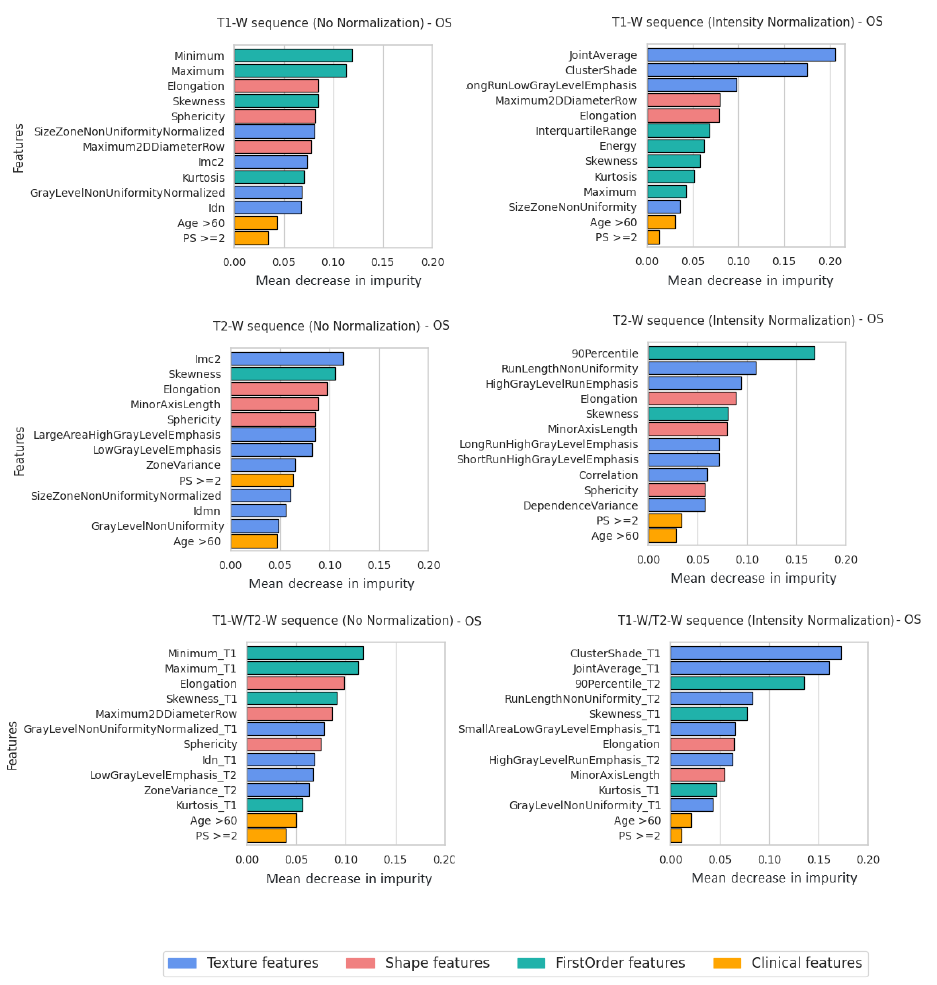
Figure 5. Feature importance for all MRIsequences with and without normalization (OS classification task). Features were grouped using different colors for shape features, texture features, first order features and clinical